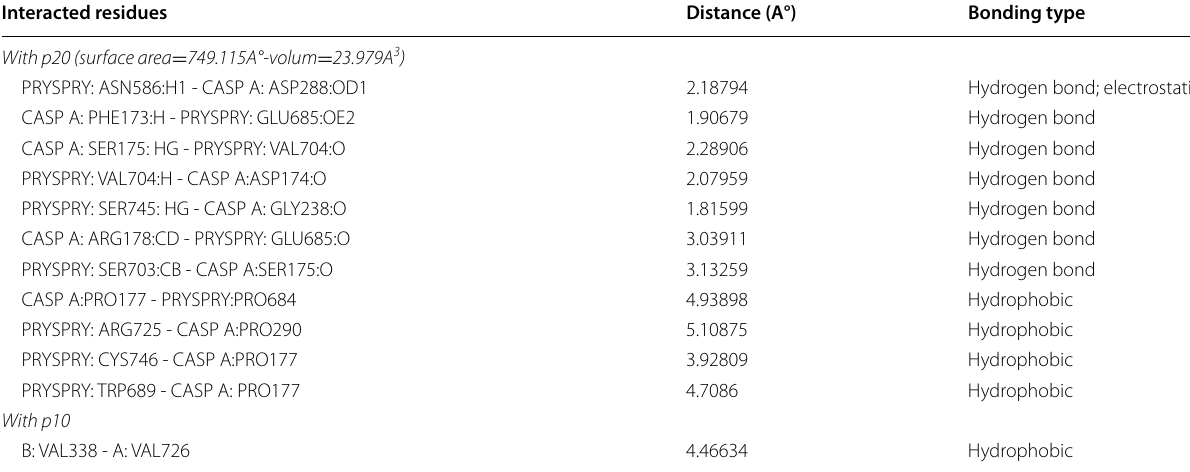
Table 1 All the modeled interacted residues between B30.2/SPRY, p20, and p10 of Casp‑1 Interacted residues Distance (A°) Bonding type With p20 (surface area 749.115A°-volum 23.979A 3 = =